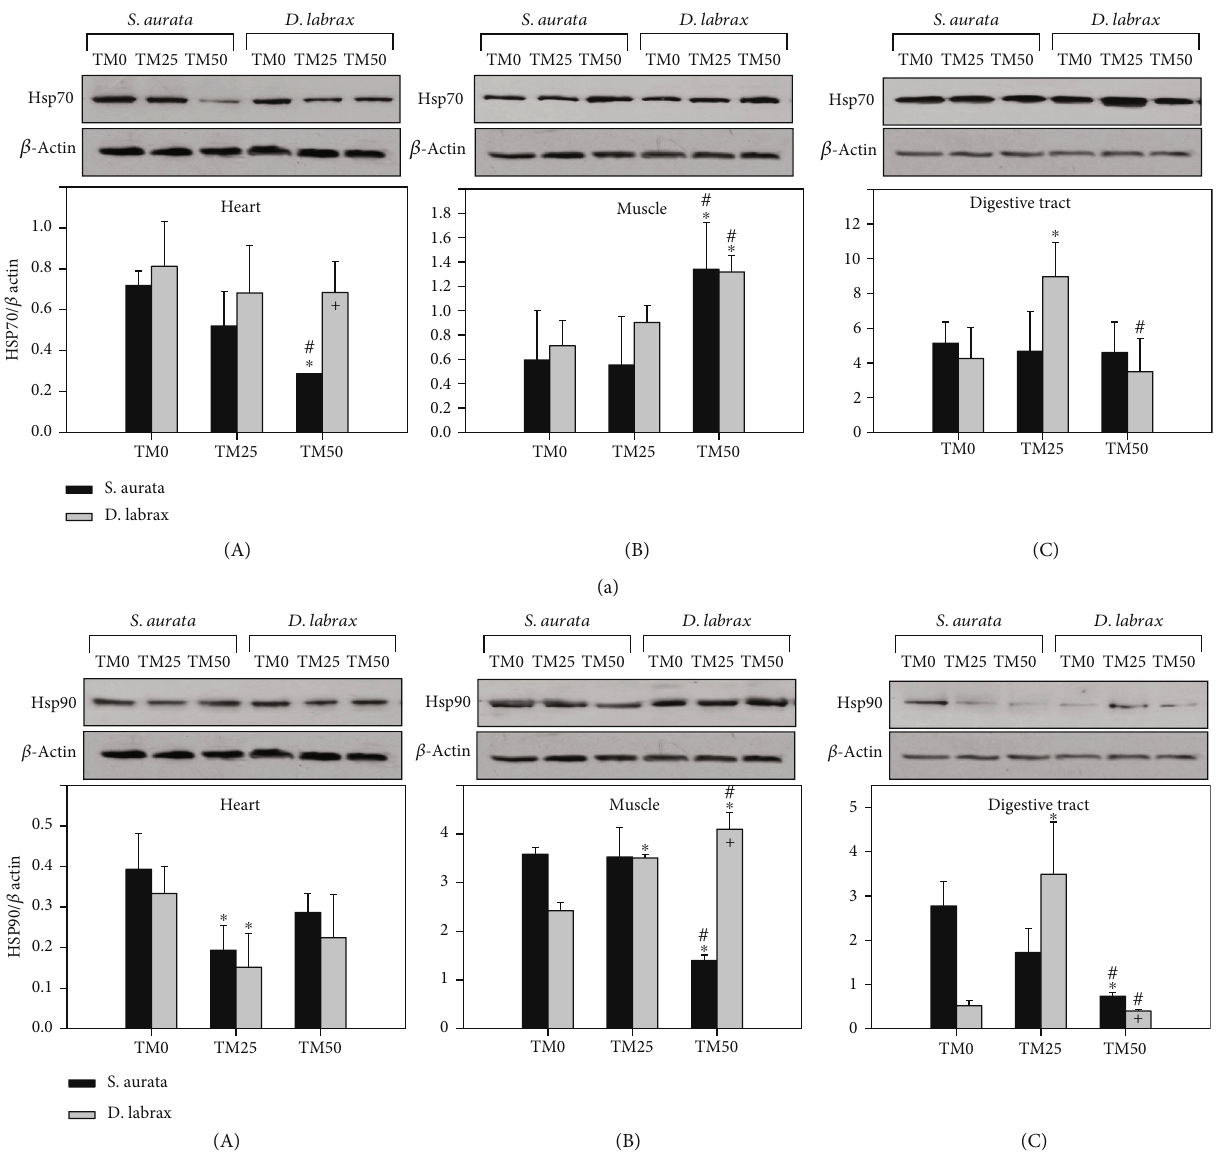
Figure 1: HSP70 (a) and HSP90 (b) in the heart (A), muscle (B), and digestive tract (C) of gilthead sea bream ( S. aurata ) and European sea bass ( D. labrax ) under the 0% (TM0), 25% (TM25), and 50% (TM50) T. molitor inclusion diet treatment. Representative immunoblots are shown and were quanti fi ed by laser scanning densitometry and plotted. Values represent means ± SD ; n = 5 preparations from di ff erent animals. ∗ indicates p < 0 : 05 compared with 0%, # indicates p < 0 : 05 compared with 25%, and + indicates p < 0 : 05 between species at the same TM